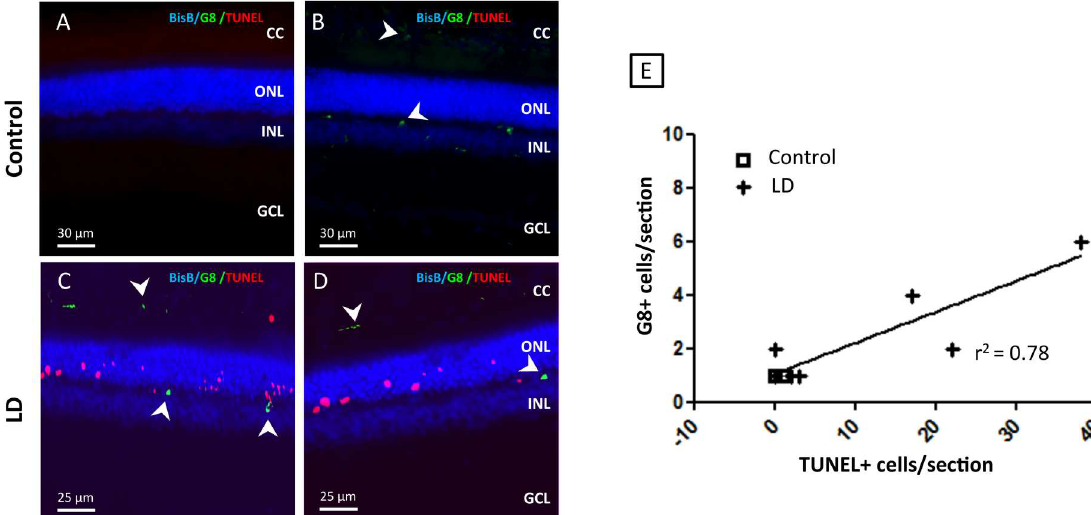
Fig 3. Severity of light-induced cell death correlateswith an increasein the number of Myo/Nog cells. Light damageand control retinas were labeledusing G8 mAb (green), a marker of Myo/Nog (cells detonated with a white ˂ ), DAPI (blue) a marker of cell nuclei and TUNEL (red) a maker of dying cells. (A,B) Representative image of control retina. Myo/Nog cells (green)are rare, but will occasionally appearin locations like the OPL and CC. We rarely, if ever will observedying photoreceptors in control animals. (C, D) Representative image of LD retina. In the light damagedretinas, we observedan increase in the TUNEL positive cells (red) and also an increasein the numberof Myo/Nog cells in the all layers, but particularlyin the OPL and RPE. (E) CorrelationbetweenG8+ (Myo/Nog cells) and TUNEL+ cells (dying photoreceptors) in LD retinal section (n = 8). r 2 = 0.78, p < 0.01 (slope significantly non-zero).CC, choriocapillaris; ILM, inner limiting membrane; INL, inner nuclearlayer; ONL, outer nuclear layer; OLM, outer limiting